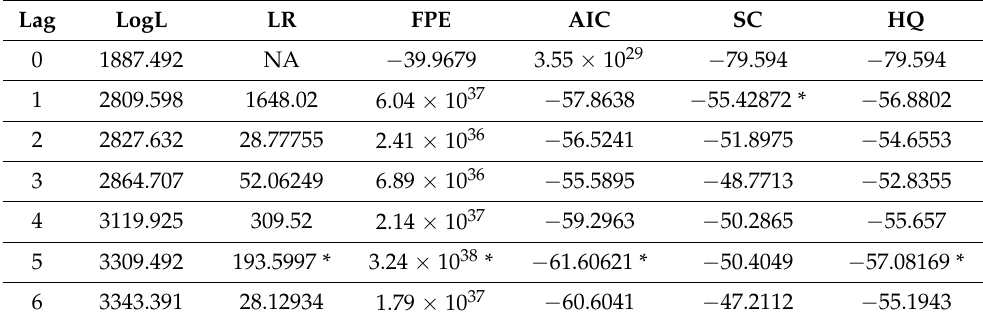
Table 5. Lag Length Selection Criteria.